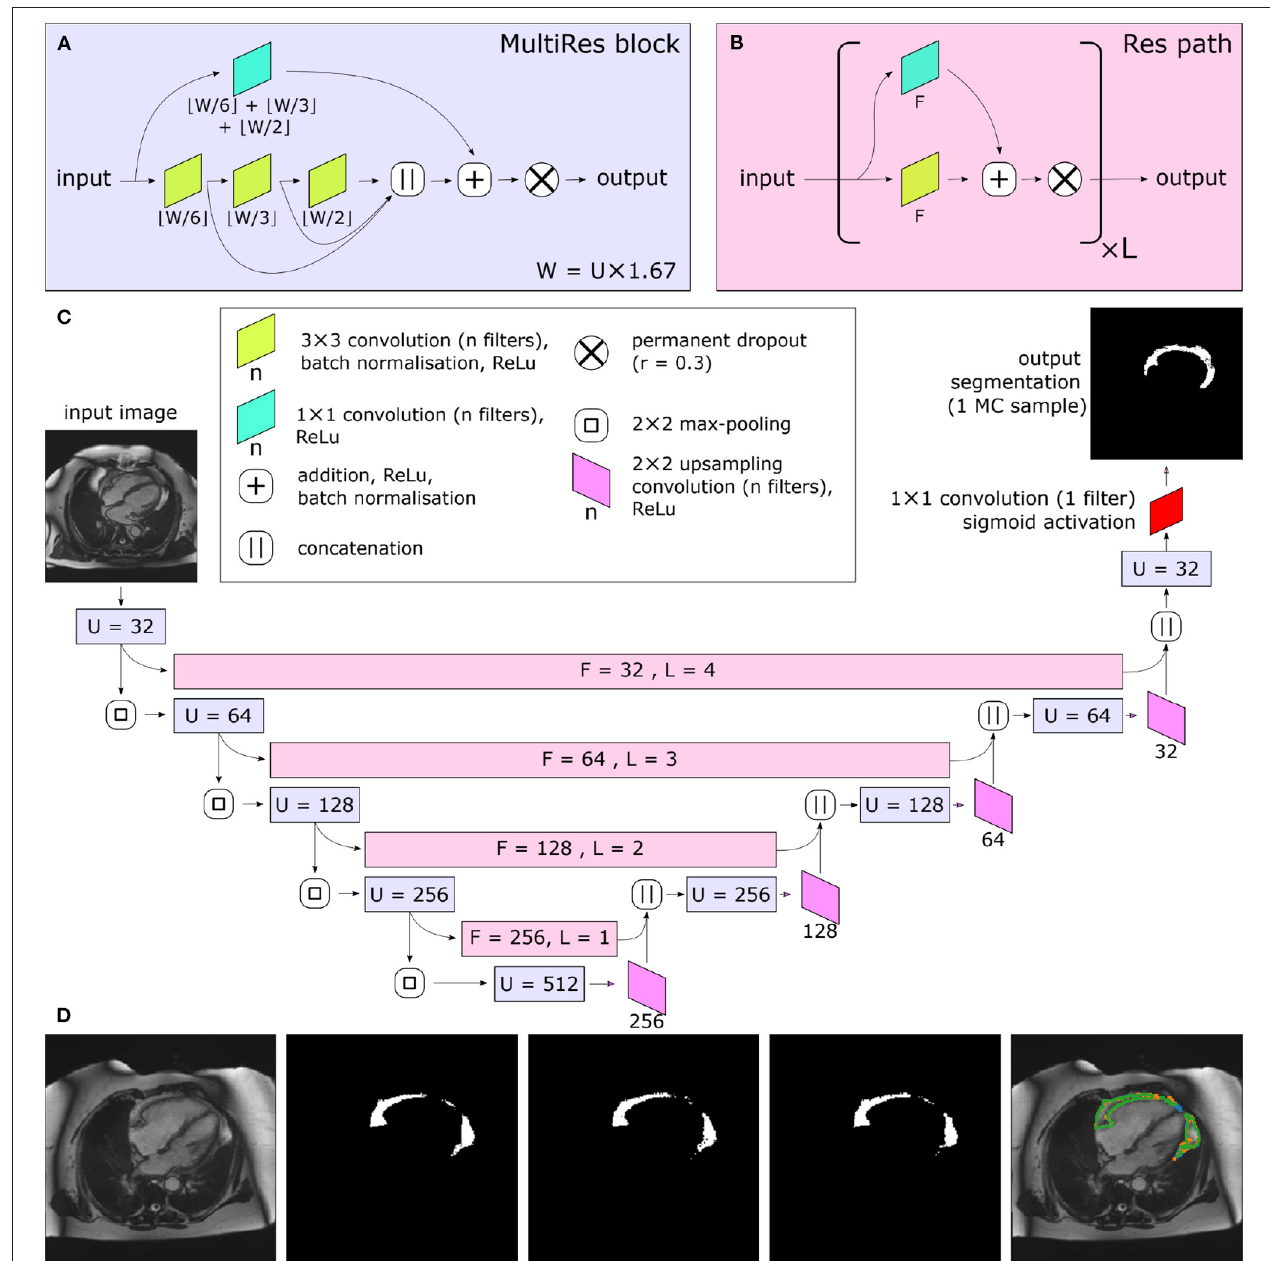
FIGURE 2 | Central illustration. Summary of model architecture used in the present study. The MultiRes blocks (A) form the encoder and decoder arms of the network. The number of filters used throughout the different components of the block is parameterized by U. The encoder and decoder arms are joined by Res paths (B) , which are parameterized by F and L. They are formed of L repeating units, and their convolutional components each have F filters. The complete network is shown in (C) . In (C) , the colors indicate the placement of MultiRes blocks (A) and Res paths (B) , while the hyperparameters used in each instance of the blocks are indicated as overlaid text. Because of the permanently active dropout components, each prediction the network makes is equivalent to a Monte Carlo (MC) sample. (D) shows three such samples drawn based on the same input image. Note the disagreement at the edges of the segmented regions, particularly clear as shown on the overlay (far right). Images reproduced with permission of UK Biobank ©